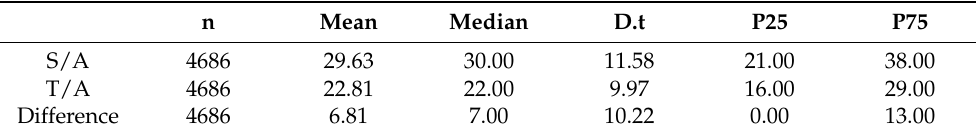
Table 9. Difference between state anxiety and trait